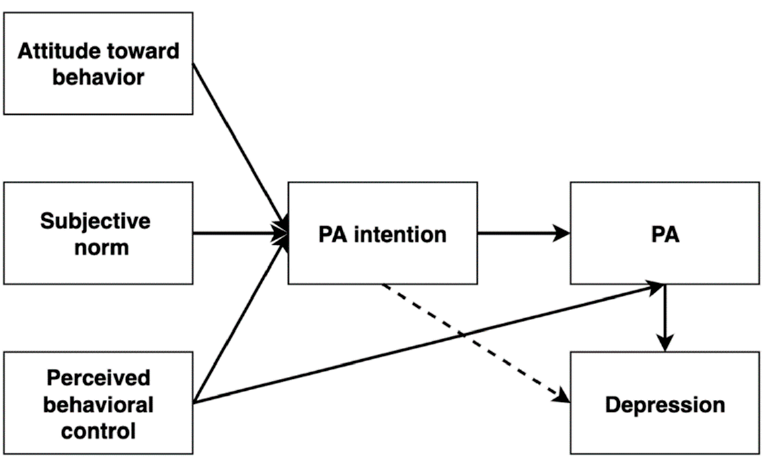
Figure 1. Hypothesized model illustrating relationships among study variables. PA = physical ac- tivity.